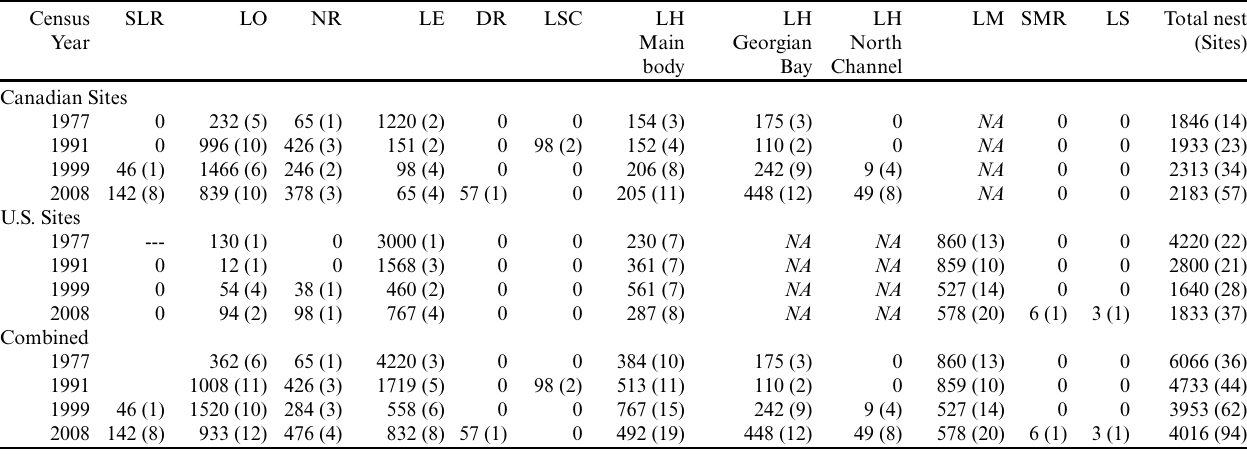
Table 1 . Location, size, and number of active Black-crowned Night-Heron ( Nycticorax nycticorax ) colonies by country and water body during the four decadal census periods. Values reflect total nest count per water body with number of active colony sites shown in parentheses. Water bodies are presented on an east-west gradient. Values of zero indicate no nesting activity reported in water body during the indicated census period. NA denotes “not applicable” because the water body does not occur in both jurisdictions. DR indicates Detroit River; LE, Lake Erie; LH, Lake Huron; LM, Lake Michigan; LO, Lake Ontario; LSC, Lake St. Clair; LS, Lake Superior; NR, Niagara River; SLR, St. Lawrence River; SMR, St. Marys